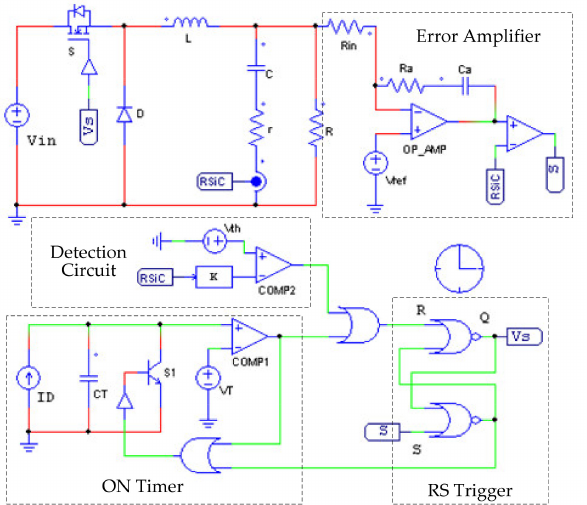
Figure 8. The PSIM simulation circuit model of the improved CC-COT-controlled buck converter.